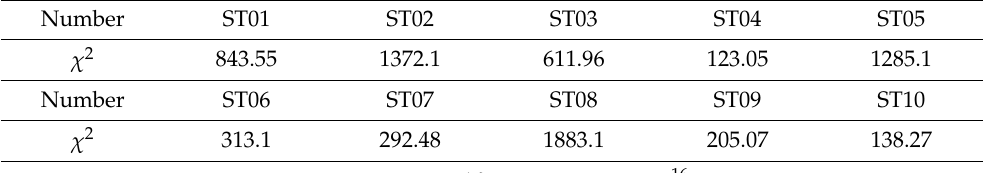
Table 2. Jarque–Bera test, data from Chinese Mainland